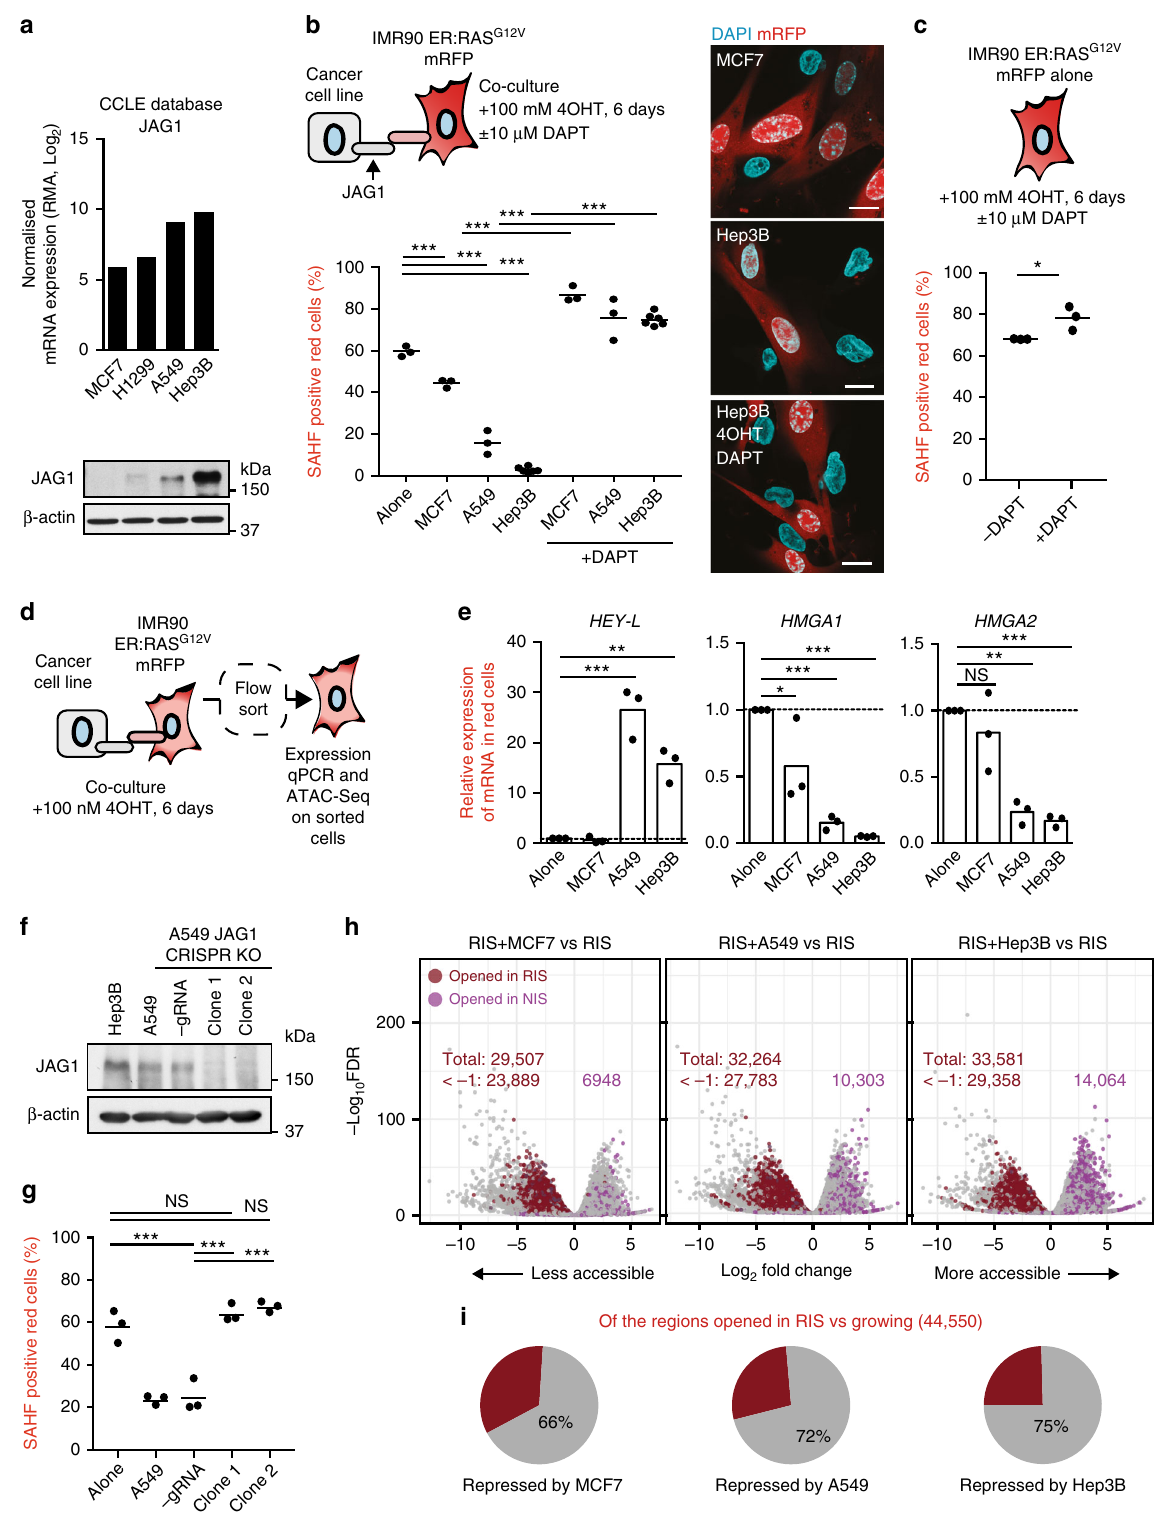
(Supplementary Fig. 5b) with the majority of opened regions mapping to enhancer, intergenic, intronic and repeat regions (Fig. 4e). Many of these repeat regions were further annotated as long interspersed elements, long-terminal repeats, short inter- spersed elements and simple repeat regions (Supplementary Fig. 5c, d), although these values may be underestimated due to